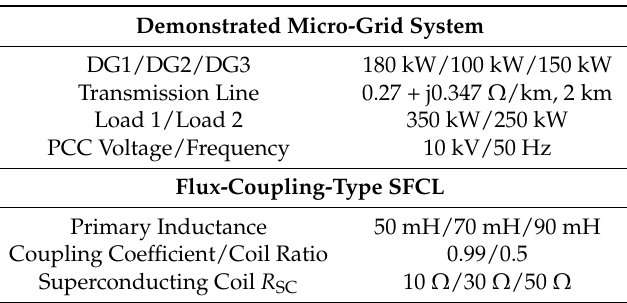
Table 1. Main simulation parameters of the demonstrated